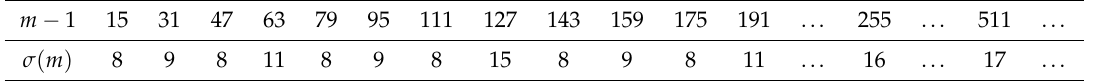
Table 1. Some S m − 1 spheres with more than seven vector